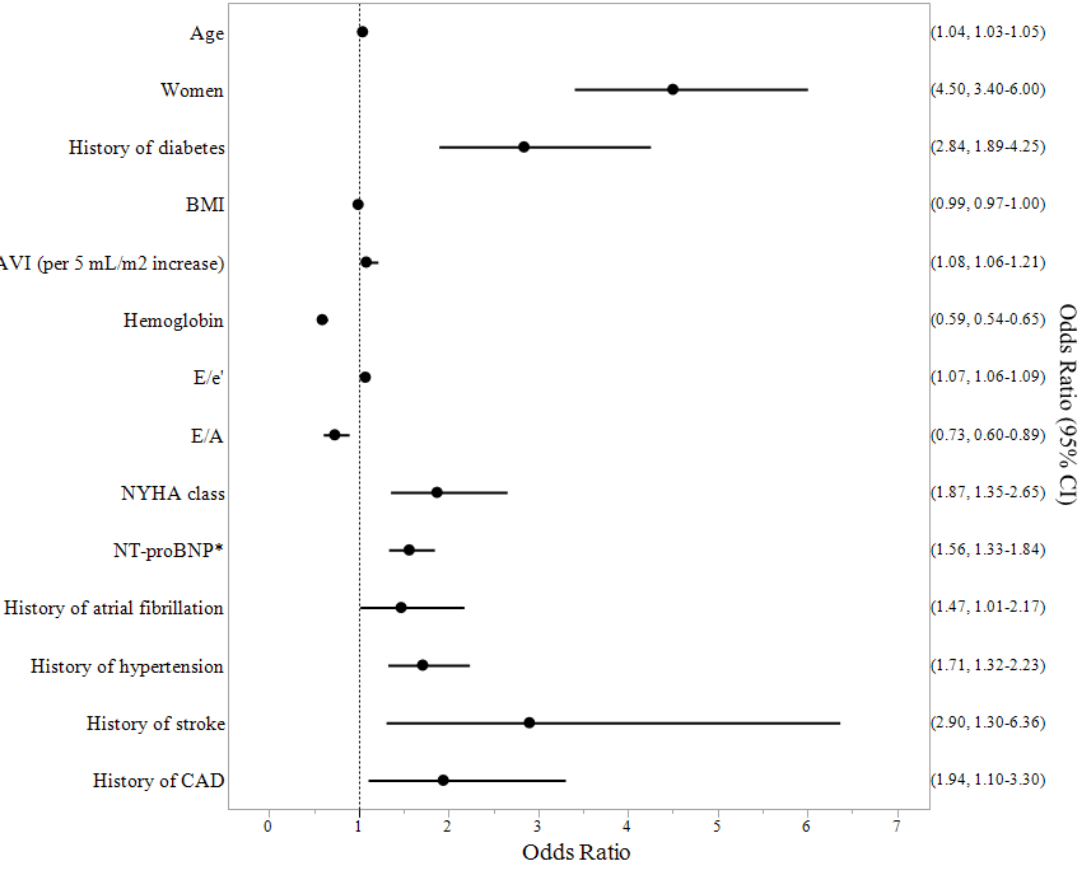
Figure 1. Univariate predictors of VO 2 peak in hypertrophic obstructive cardiomyopathy (HOCM) patients. Significant predictors of the lowest VO 2 peak were age, female sex, BMI, left atrial volume index (LAVI, per 5 mL/m 2 increase), hemoglobin, E/e’, E/A, NYHA class, NT-proBNP, and histories of atrial fibrillation, hypertension, stroke, and coronary artery disease (CAD). * per each SD increase. Odds ratio and 95% confidence interval shown for each variable.